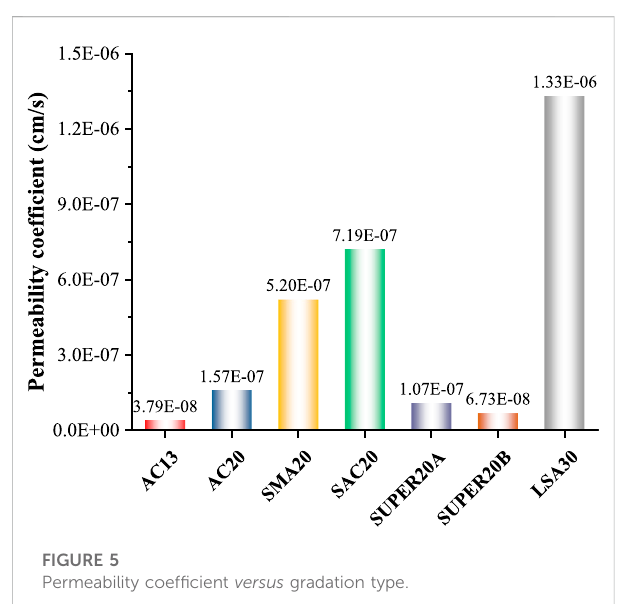
FIGURE 5 Permeability coef fi cient versus gradation